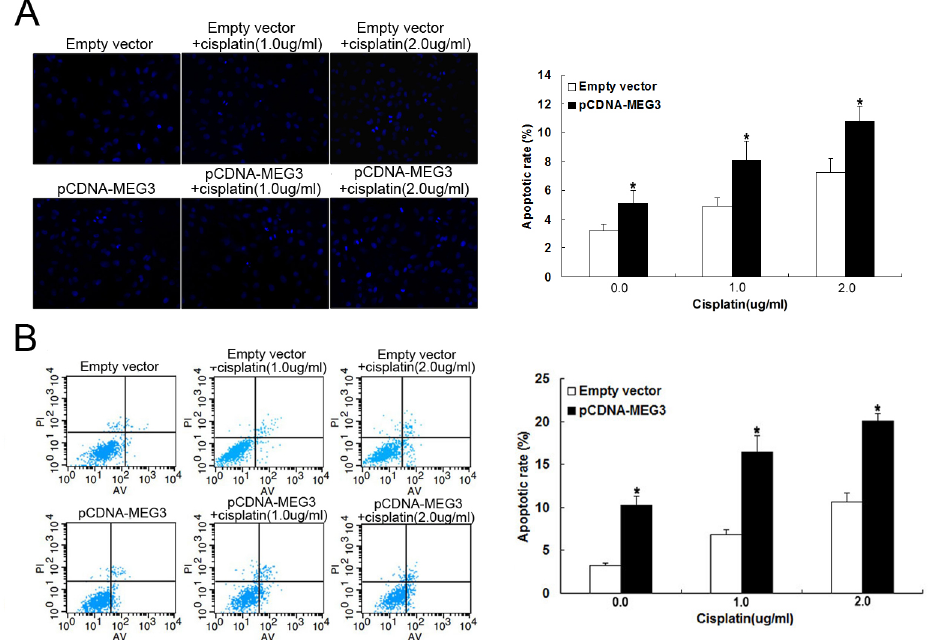
Fig 2. MEG3 overexpression promotes A549/DDP cell apoptosis in vitro . (Fig 2A) Hoechst staining assay for cell apoptosis; the percentage of Hoechst-positive nuclei per optical field (at least 50 fields) was counted. (Fig 2B) Flow cytometry analysis of apoptosis in transfected A549/DDP cells in combination with increasing concentrations of cisplatin (0.0, 1.0, and 2.0 μ g/ml). * P < 0.05.